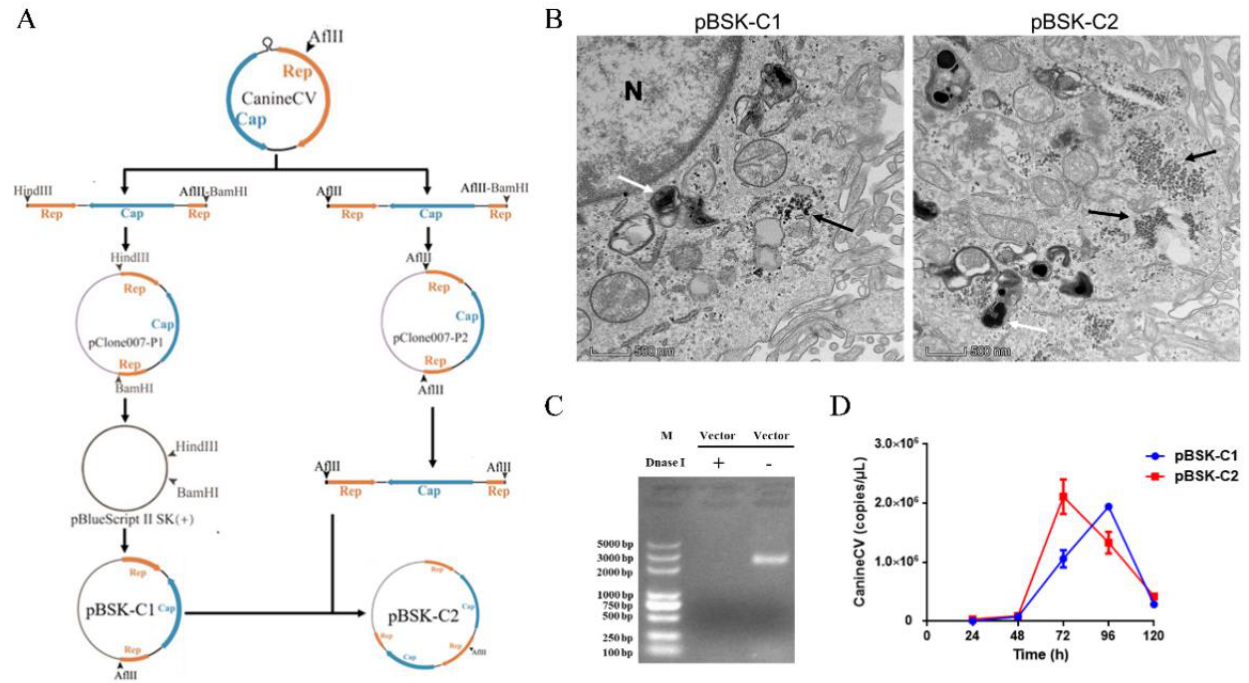
Figure 1. CanineCV rescue. ( A ) Schematic diagram of the steps for constructing the CanineCV